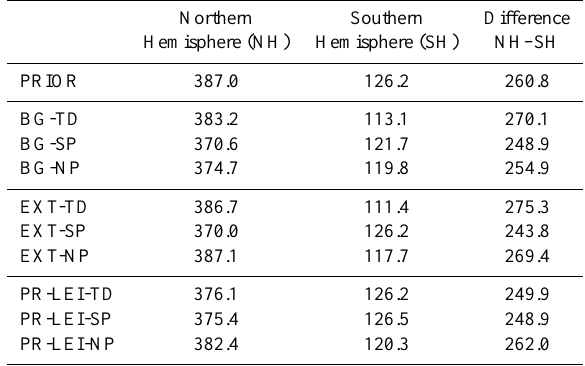
Table 1. Annual hemispheric methane fluxes (TgCH 4 year − 1 ) for the common year of simulation